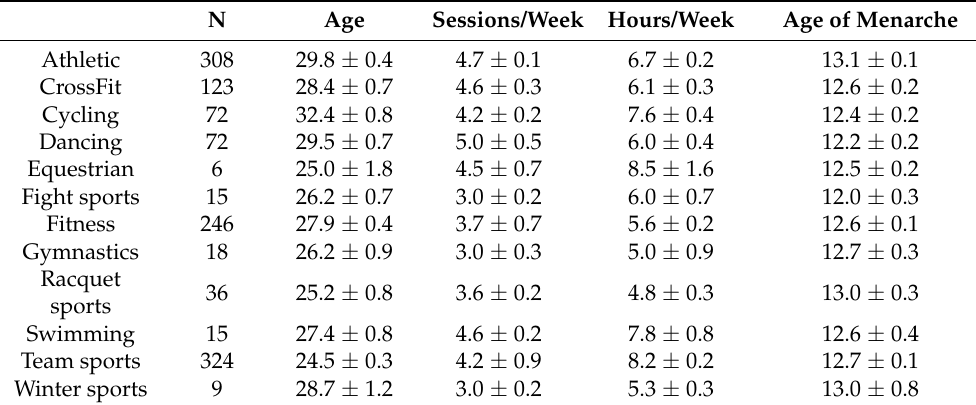
Table 1. Descriptive data of active women related to sport modality.